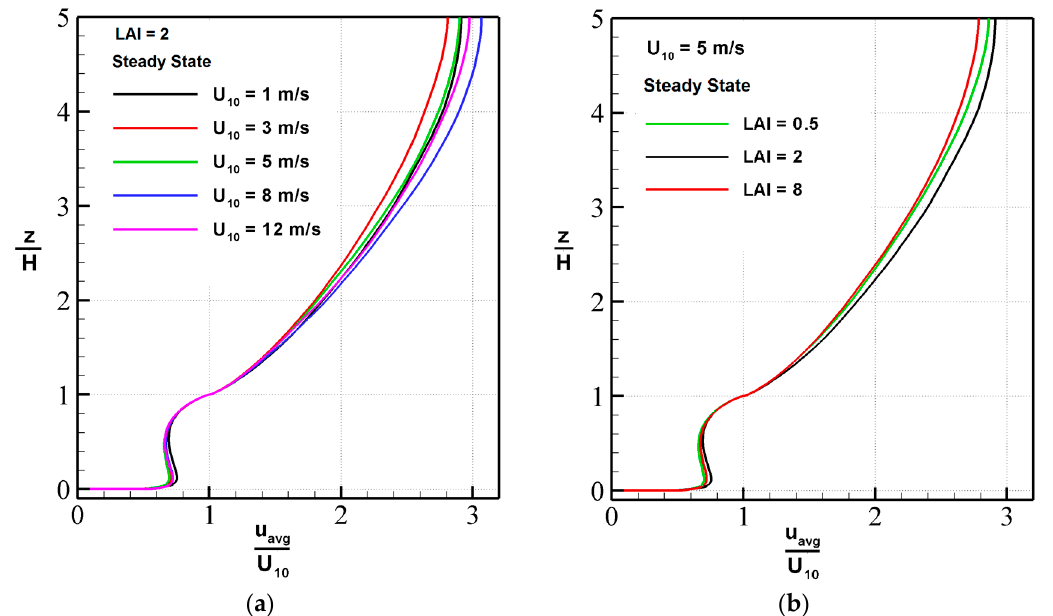
Figure 5. Effect of the wind speed ( a ) and the canopy LAI ( b ) on the normalized velocity profile u ( z ) (averaged in the x and the y directions and in time between t = 1200 s and t = 1500 s) obtained at steady state.